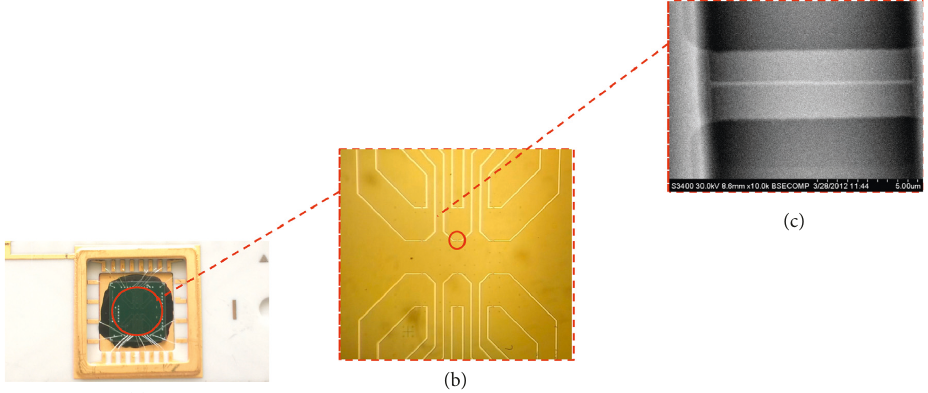
Figure 1: (a) Sensor chip with an array of SOI–NWs, (b) optical image of 12 SOI–NWs arranged in pairs on the chip surface, and (c) electron microscopy image of a single SOI-NW.